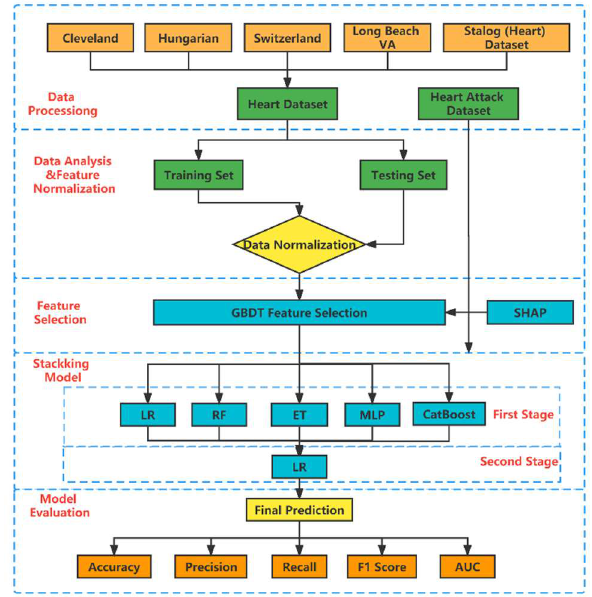
Figure 1. Prediction process flow chart.